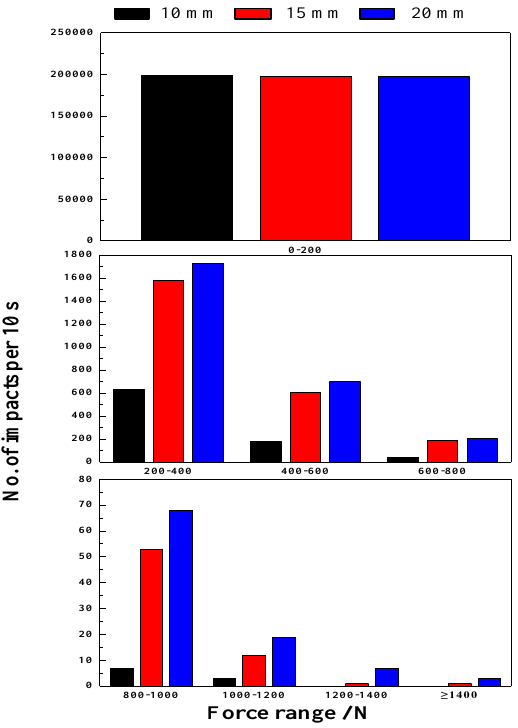
Figure 12. Impact force at different lifter heights.